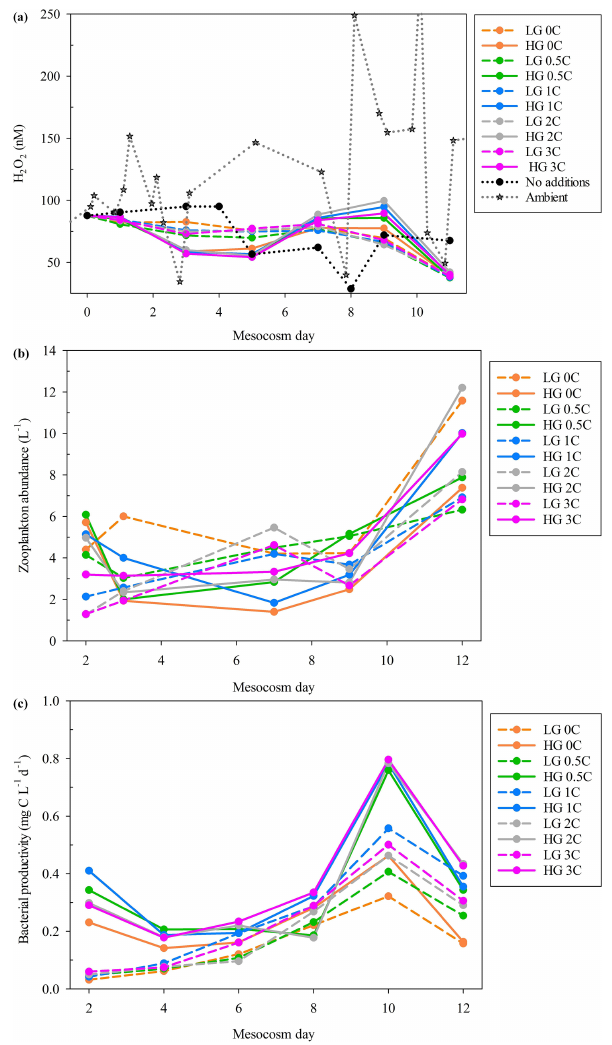
Figure 2. (a) H 2 O 2 in all mesocosms during MesoMed in Gouves, Crete. A 10-treatment matrix (as per Fig. S1) was used. (b) Zoo- plankton abundances showed a rapid convergence in the HG–LG (high-grazing, low-grazing) status of the mesocosms after day 2. (c) The trend in bacterial productivity showed broad similarity within the HG and LG treatment groups.